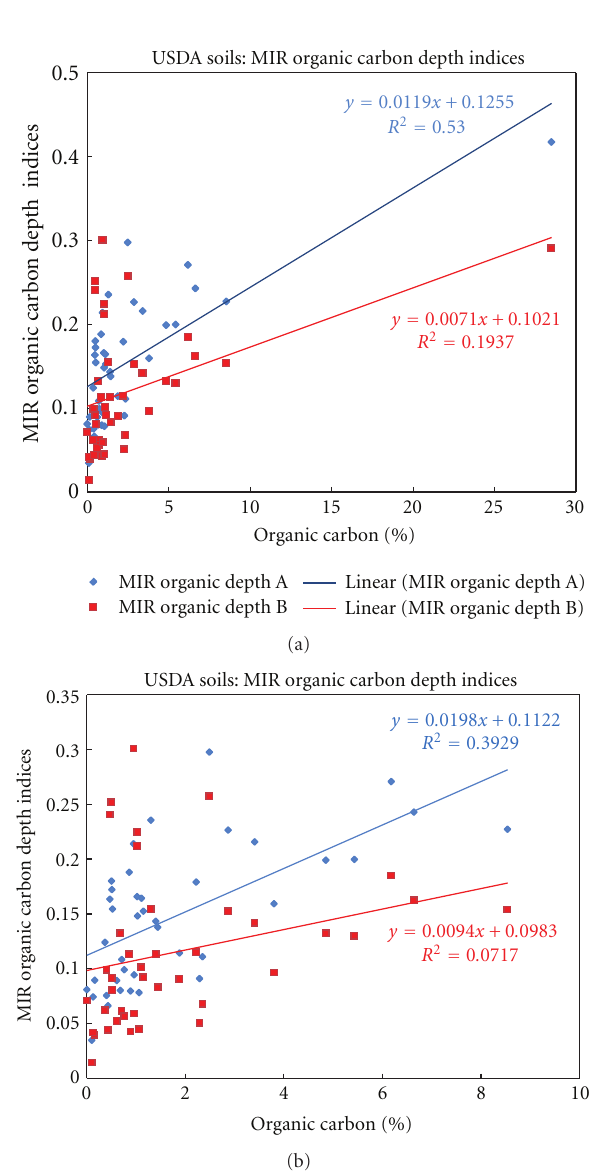
Figure 16: MIR organic carbon depth indices A and B versus the USDA organic carbon content; (a) for all data; (b) omitting outlying organic carbon rich sample at